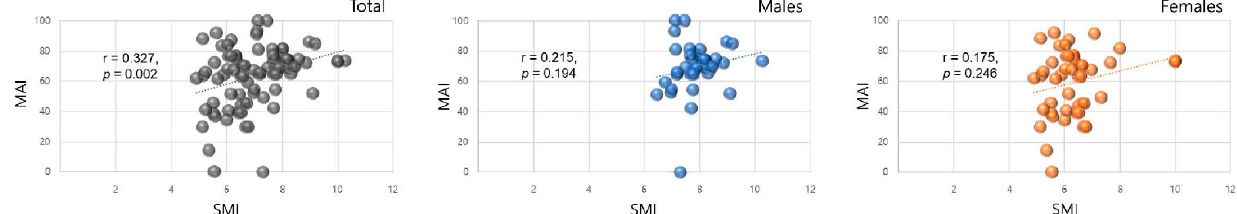
Figure 3. Correlation between the skeletal muscle mass index (SMI) and the mixing ability index (MAI).